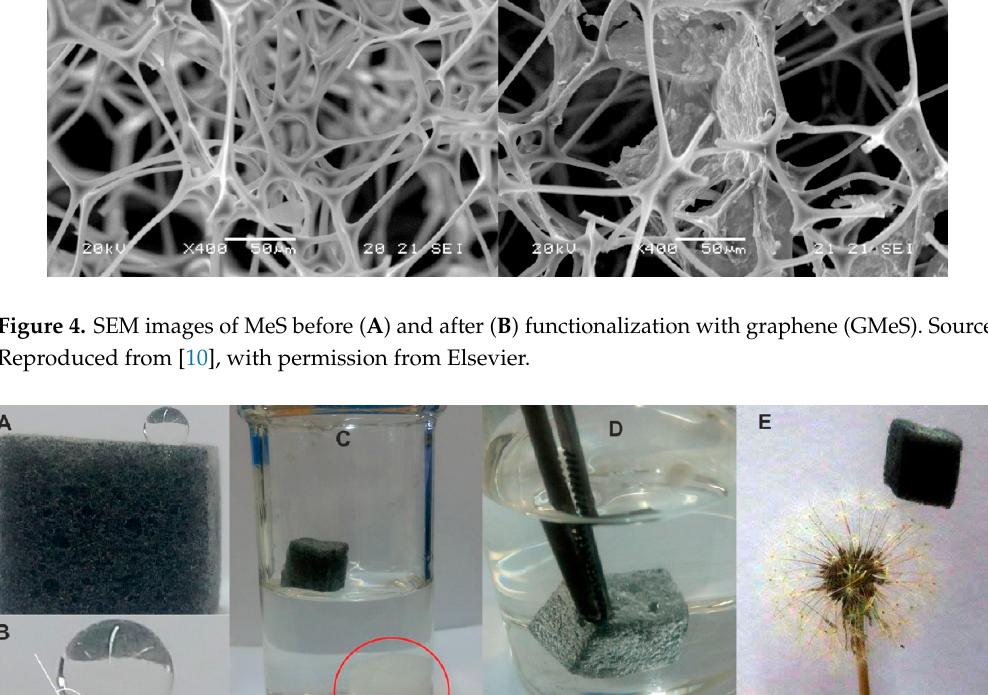
Figure 6. Copper mirror formed on the surface of the reaction glass beaker during the decoration of MeS ( A ). The produced CuMeS ( B ) and its behavior in water ( C , D ). Source: Reproduced from [11], with permission from Elsevier . In another study, graphene-modified MeS were functionalized with β -cyclodextrin [69]. The synthesis procedure consisted of multiple steps: Firstly, MeS was dipped into a GO solution and dried. Then, the sponges were placed into a solution of β -cyclodextrin (previously modified with aminopropyl tetraethoxysilane), removed after 2 h, and left to dry overnight. The modification procedure was repeated once more, resulting in the final material. The sponges were used for the extraction of flavonoids. The developed material is new and has some advantages, but the synthesis is time-consuming. MeS functionalized with β -cyclodextrin and graphene was also proposed [70]. An MeS cube was added into a β -cyclodextrin and graphene dispersion, and then ammonia solution was added to adjust pH to 10. After adding hydrazine and heating, the modified MeS was dried. The developed sponges could be used for the extraction of malachite green. The presence of β -cyclodextrin was found to significantly affect the adsorption, since sponges prepared with lower amounts of β -cyclodextrin had lower sorption efficiency. The sponges were employed to extract